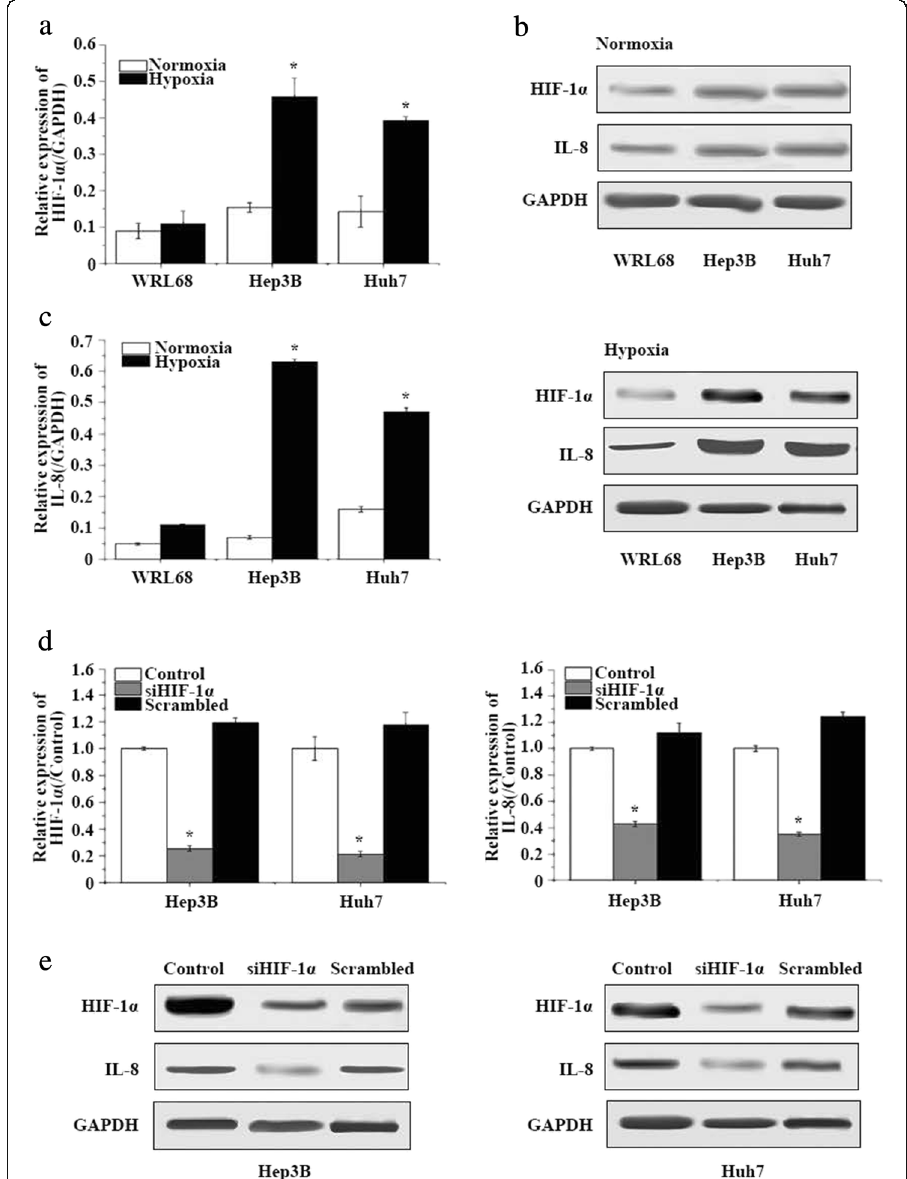
Fig. 1 HIF-1 α is associated with the migration and invasion of human hepatocarcinoma (HCC)cells by regulating IL-8 expression under conditions of hypoxia . a Relative HIF-1 α mRNA levels in human HCC cell lines and the normal liver cell line WRL68. n = 3; * p < 0.05. b HIF-1 α and IL-8 protein levelsin HCC cell lines and the normal liver cell line WRL68. GAPDH was used as the loading control. c Relative IL-8 mRNA levels in human HCC cell lines and the normal liver cell line WRL68. n = 3; * p < 0.05. d The efficiency of HIF-1 α knockdown in HCC cell lines (left panel) and the effect on IL-8 expression (right panel) were evaluated using quantitative RT-PCR. e Western blot analysis of HIF-1 α and IL-8 protein expression in HCC cell lines treated with siHIF-1 α . GAPDH was used as a control. n = 3; * p <